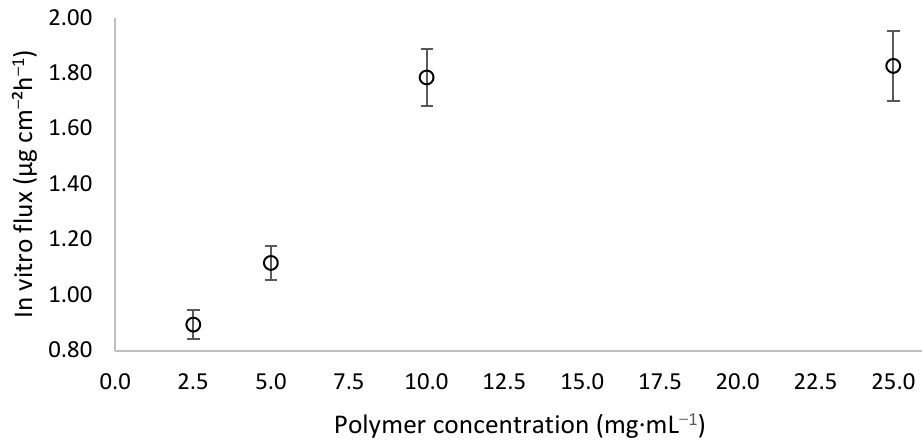
Figure 9. Impact of steady-state flux as a function of polymer concentration through Strat-M ® membrane. Average values were determined from 6 separate trials.